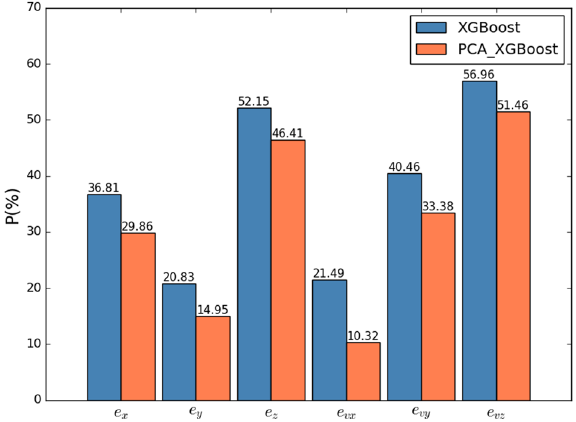
Figure 5: Comparison of XGBoost and PCA – XGBoost model for six components in the testing dataset ( training in week → 1 3 and testing in week 4 )